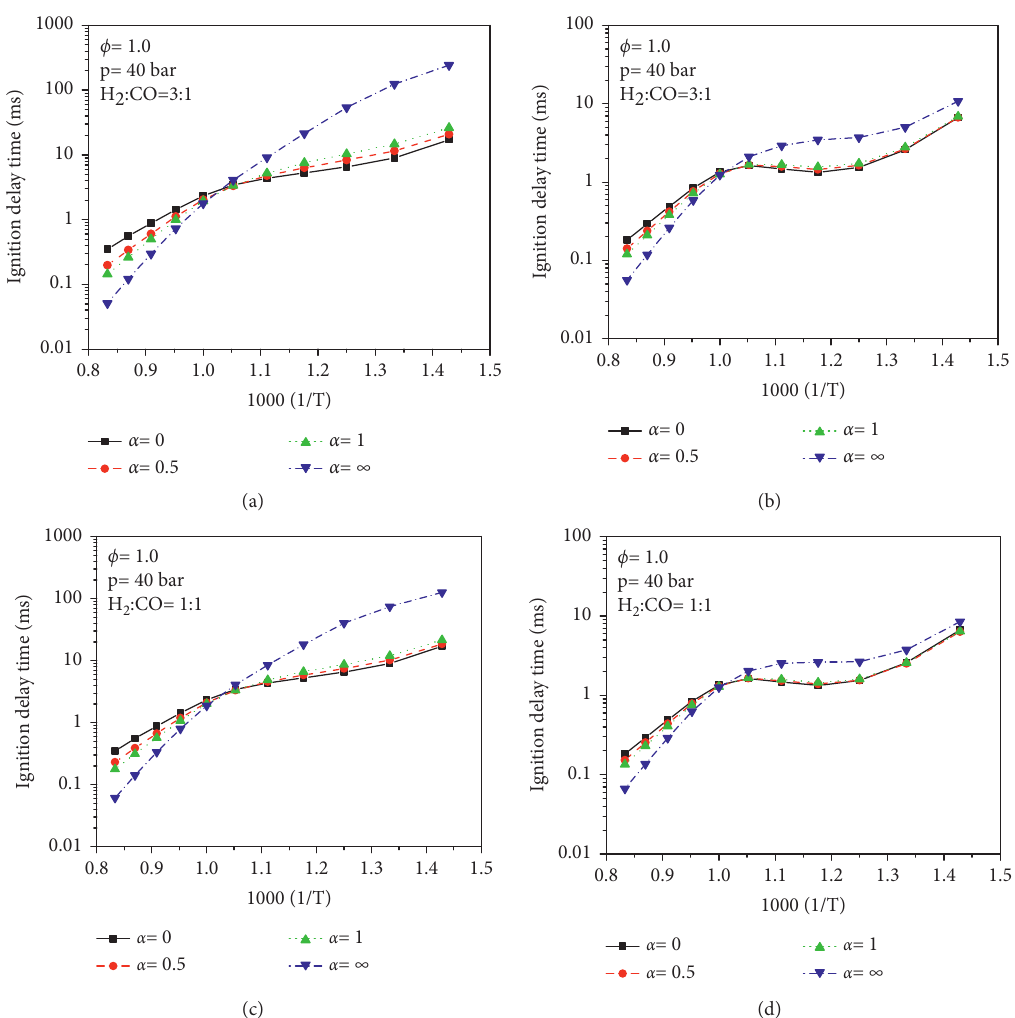
Figure 14: Ignition delay time of different α values for methane/syngas/n-heptane mixtures, (a) and (c) β � 2.112 × 10 − 2 , (b) and (d) β � 4.545 × 10 − 2